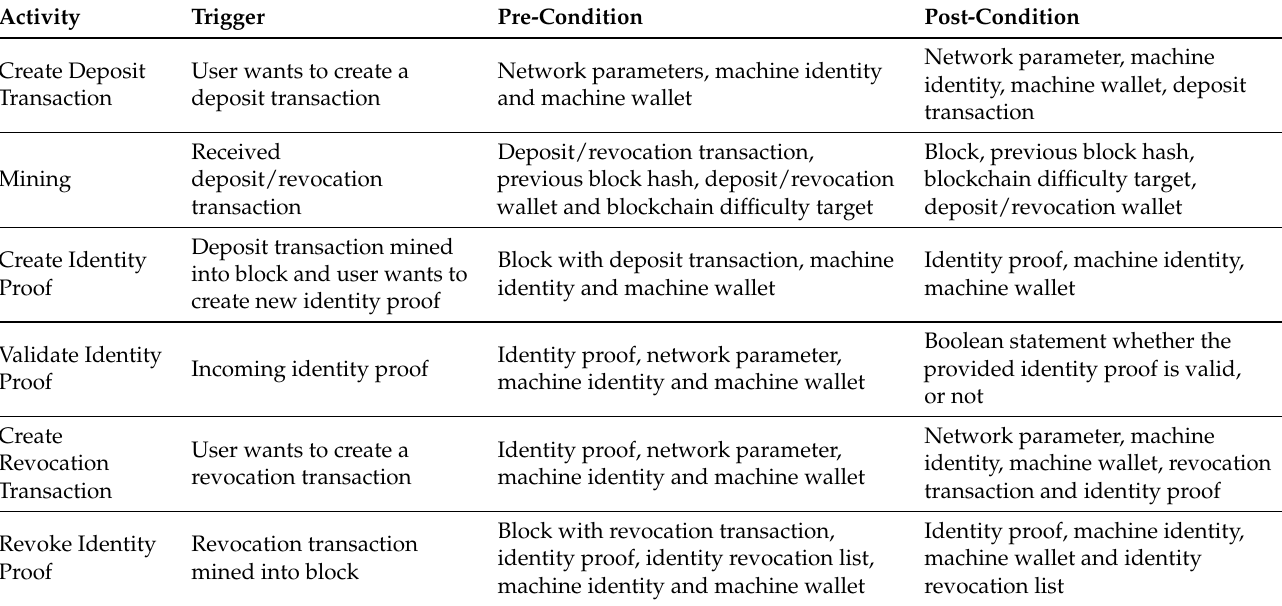
Table 2. Behavioral interfaces of activities for Rechained—extension of [5].